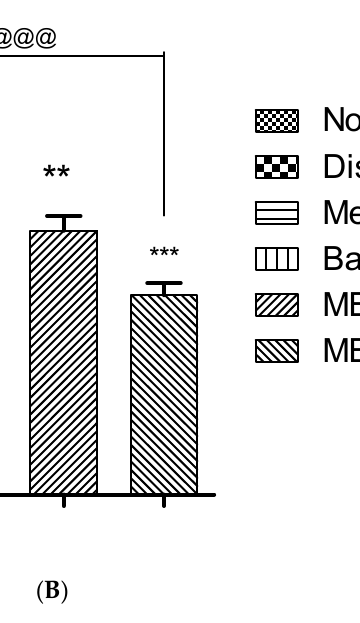
Figure 5. ( A ). Effect of A β (1–42) , baicalein and baicalein with memantine on AChE in the rat brain hippocampus. Data are represented as mean ± SEM (n = 6), where ### p < 0.001 indicates comparison with normal control, * p < 0.05, ** p < 0.01 and *** p < 0.001 indicates comparison with disease control group, whereas @@ p < 0.01 and @@@ p < 0.001 indicates comparison with memantine (20 mg/kg) group. SEM: Standard Error of Mean. ( B ). Effect of A β (1–42) , baicalein and baicalein with memantine on AChE in the rat brain cortex.